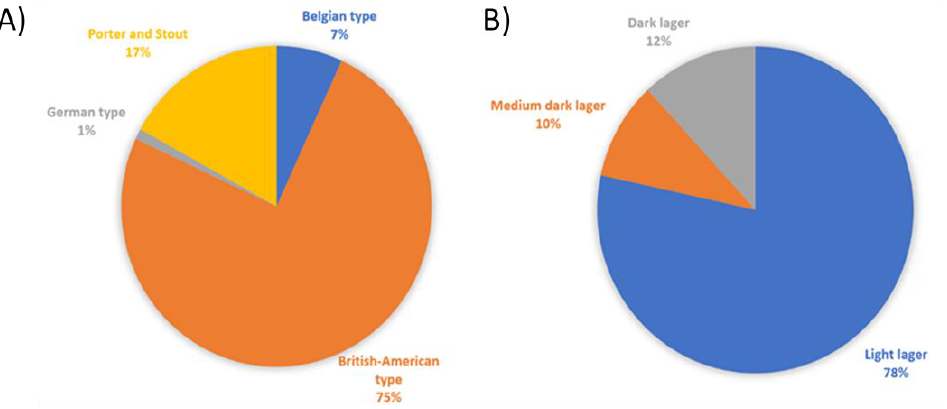
Figure 3. Pie-chart illustrating the representative % of the different types of “ale” ( A ) and “lager” beers ( B ).